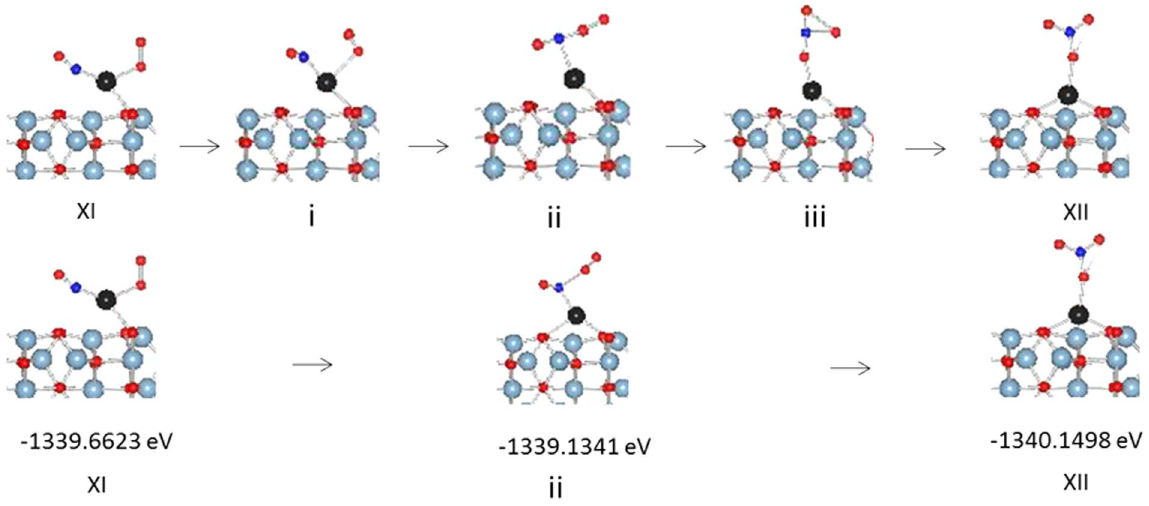
Figure 9. Transition States in nitrate